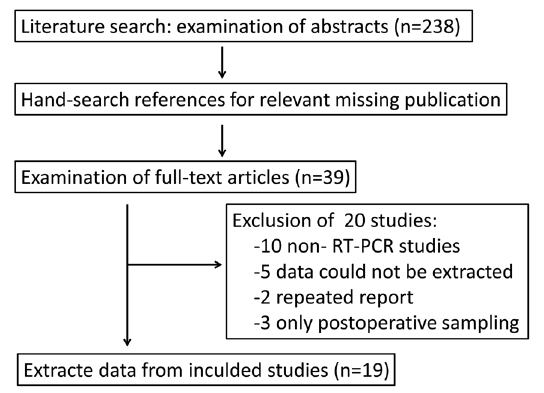
Figure 1. Flowchart of studies screening process.